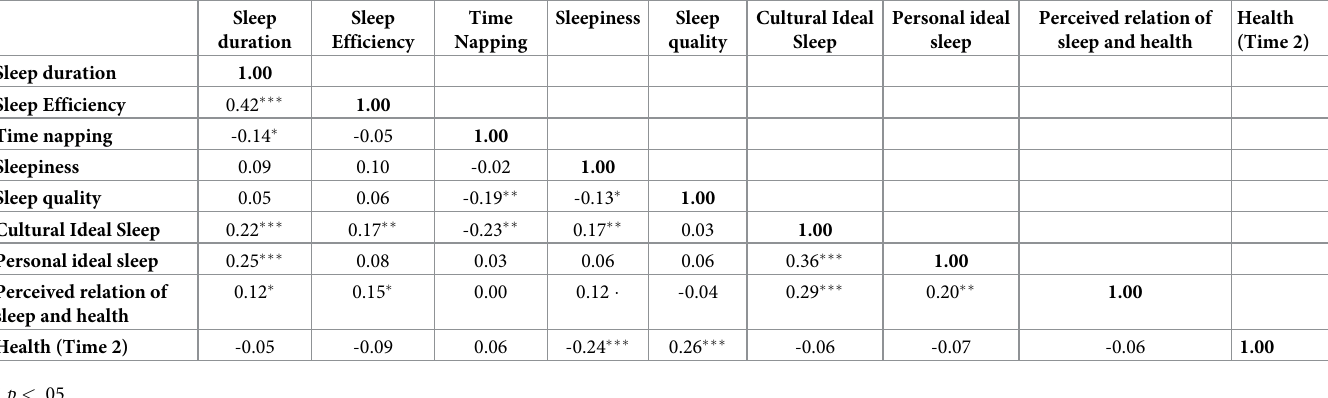
Table 2. Correlation matrix of all